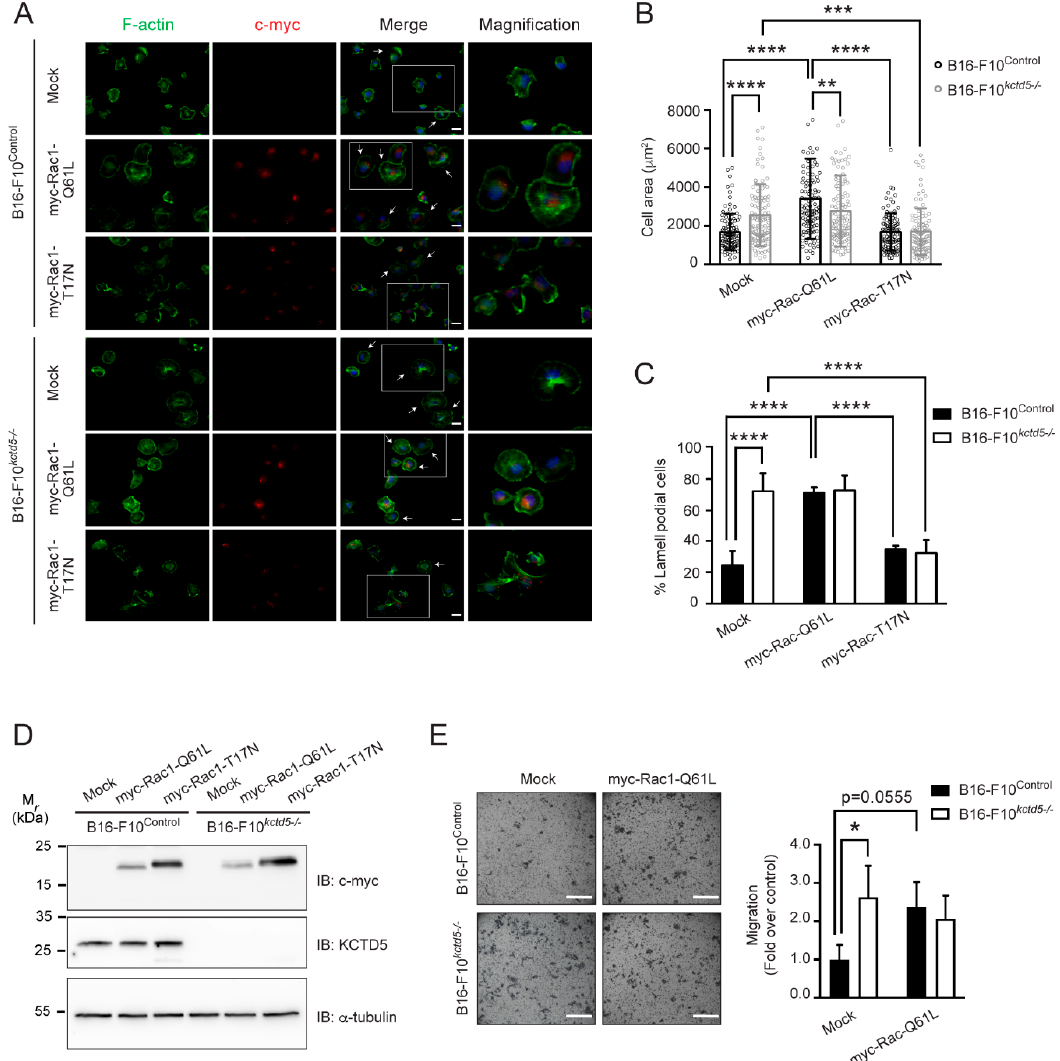
Figure 3. KCTD5 regulates cell spreading and migration through Rac1. ( A ) Representative images of B16-F10 Control and B16-F10 kctd5- / - cells transfected with empty vector (Mock), myc-Rac1-Q61L (constitutively active) or myc-Rac1-T17N (dominant-negative) encoding plasmids. Cells were seeded on fibronectin-coated coverslips for 45 min, fixed and stained for F-actin with Alexa-488 phalloidin (green). Rac1 mutants-transfected cells were labeled with mouse mAb anti-c-myc (red). Arrows show lamellipodial-like cells. White boxes show magnification area. Scale bar = 0.20 µm. ( B ) Graph representing the cell area (µm 2 ) for each condition (mean ± SD; n = 4; Two-way ANOVA followed by Tukey’s and Sidak’s multiple comparisons tests, ** p < 0.01, *** p < 0.001, **** p < 0.0001). ( C ) Graph representing the percentage of lamellipodial-like cells for each condition (mean ± SD; n = 4; Two-way ANOVA followed by Tukey’s and Sidak’s multiple comparisons tests, **** p < 0.0001). ( D ) Representative immunoblot showing levels of myc-Rac1-Q61L (constitutively active), myc-Rac1-T17N (dominant-negative) and KCTD5 in B16-F10 Control and B16-F10 kctd5- / - cells transfected with empty vector (Mock), myc-Rac1-Q61L or myc-Rac1-T17N encoding plasmids. α -tubulin was used as loading control. ( E ) Transwell Boyden chamber migration assays of B16-F10 Control and B16-F10 kctd5- / - cells transfected with empty vector (Mock) or myc-Rac1-Q61L encoding plasmid. Cells were stimulated with 10 % v / v serum for 18 h. Scale bar = 500 µm. Graph represents the relative migration for each condition (mean ± SD; n = 3; Two-way ANOVA followed by Sidak’s multiple comparisons tests, * p < 0.05).